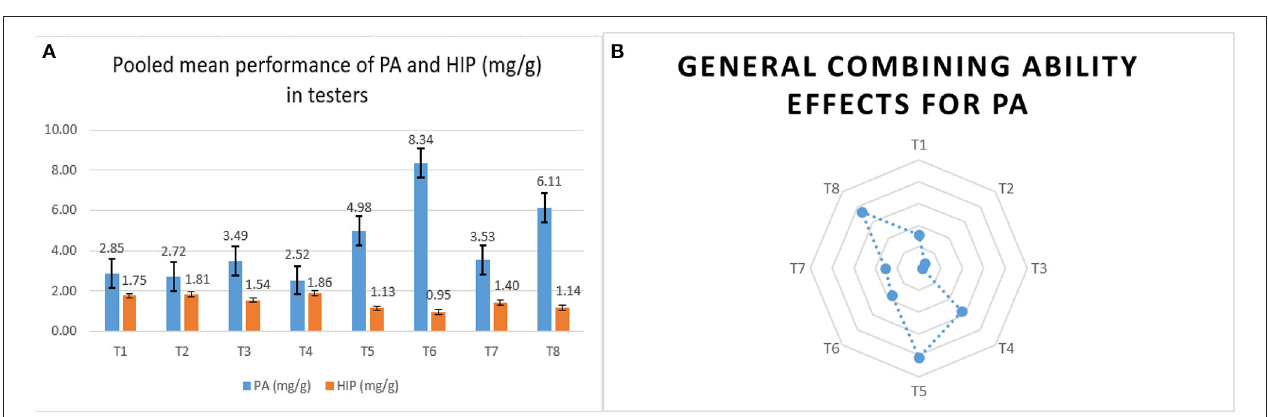
FIGURE 3 | The overall mean performance and combining ability of the male testers. (A) The comparative pooled mean performances of PA and HIP in mg/g in male testers. (B) The overall performance of male testers in crosses ( gca ) for PA content.